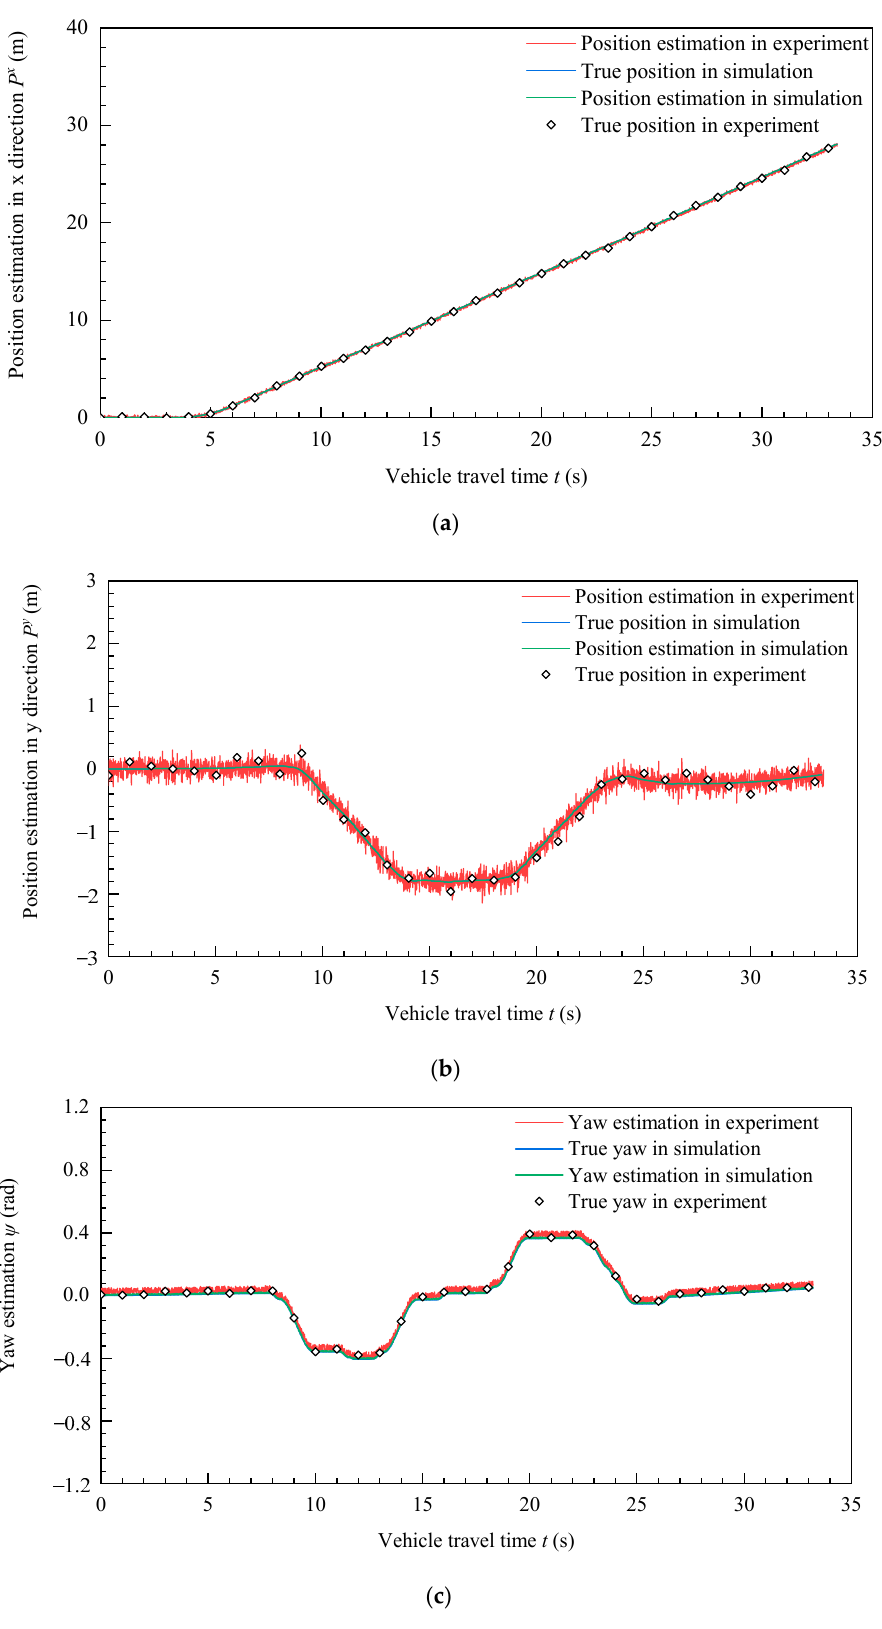
Figure 9. Position and attitude estimation of double lane shifting driving path. ( a ) Position estimation in x direction. ( b ) Position estimation in y direction. ( c ) Yaw estimation.